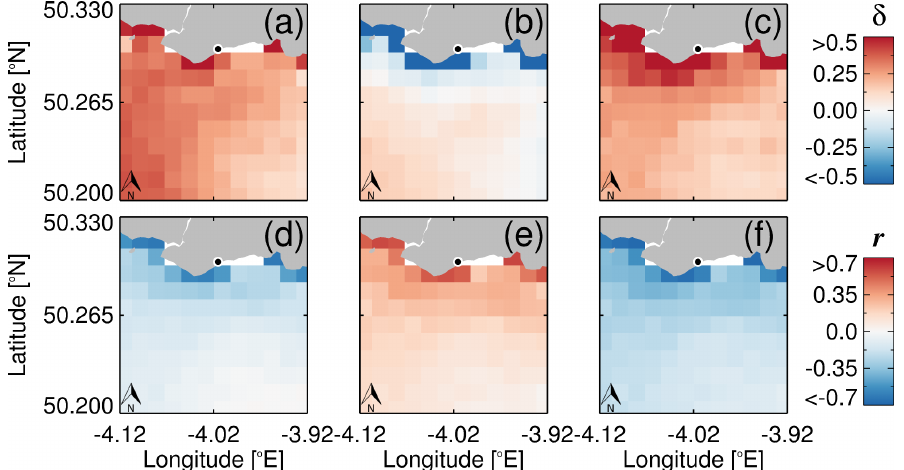
Figure 7. ( a ) Spatial maps (per-pixel) of the mean bias ( δ ) between AVHHR SST N data and in situ kelp site data (within ± 1h) during the day (solar zenith angle <90 ◦ ); ( b ) during the night (solar zenith angle >90 ◦ ); and ( c ) the difference between ( a , b ), i.e., day δ minus night δ ; ( d ) shows per-pixel Pearson correlations ( r ) between solar zenith angle and the differences between satellite AVHRR SST N data and in situ temperature from the kelp site; ( e ) the same as ( d ) but using land surface temperature (LST) rather than solar zenith angle; ( f ) the same as ( d ) but using SST (kelp site) minus LST, rather than solar zenith